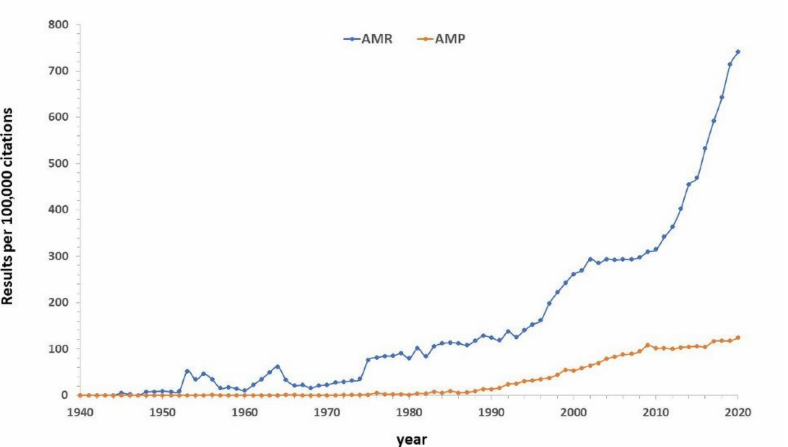
Figure 1. Publication trend related to antimicrobial resistance (AMR, blue trace) and antimicrobial peptide (AMP, red trace) in Pubmed during the period 1940–2020. Search terms used for AMR: drug resistance, antimicrobial resistance, or antibiotic resistance either in the title or abstract. Search terms used for AMP: peptide and (antimicrobial or antibacterial or antiviral or antifungal or antiparasitic) either in the title or abstract. For a suitable comparison, every set of data was normalized to the number per 100,000 results/year from Pubmed. The search was conducted by Pubmed by Year (https://esperr.github.io/pubmed-by-year/ (accessed on 5 September 2021)). Both traces represent an increasing interest in AMR and AMP, especially during the last 30 years. Concern about AMR has boosted the research on the topic to have an exponential